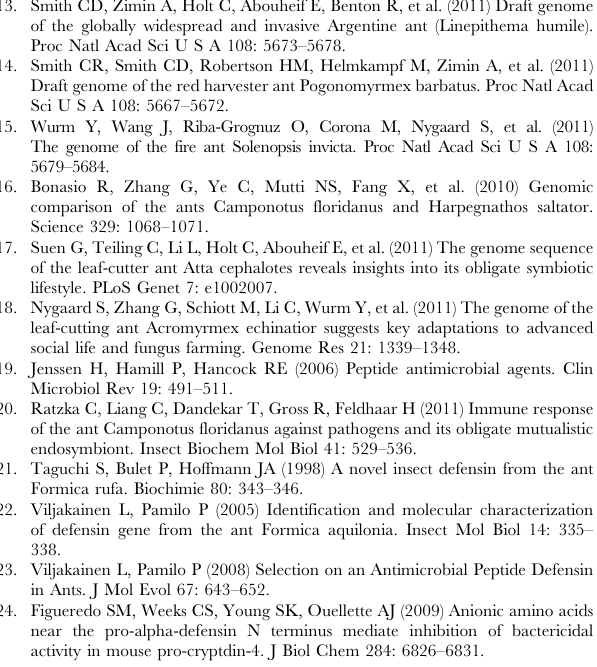
Table S1 tBLASTn summary of defense peptides and peptide toxins. Table S2 tBLASTn summary of neuropeptides and regulatory peptide